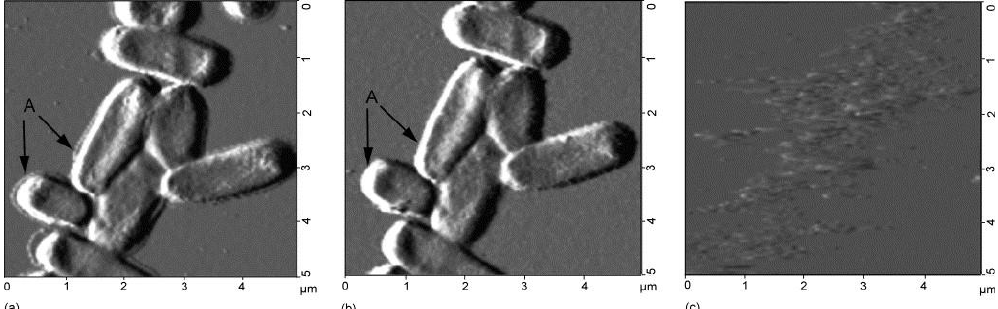
Figure 5. AFM images of E. coli cells on the TiO 2 film: ( a ) no illumination; ( b ) illumination for 1 day; ( c ) illumination for 6 days. Light intensity was 1.0 mW/cm 2 . Adapted with permission from [106] ; Copyright 2003 Elsevier Science B.V.